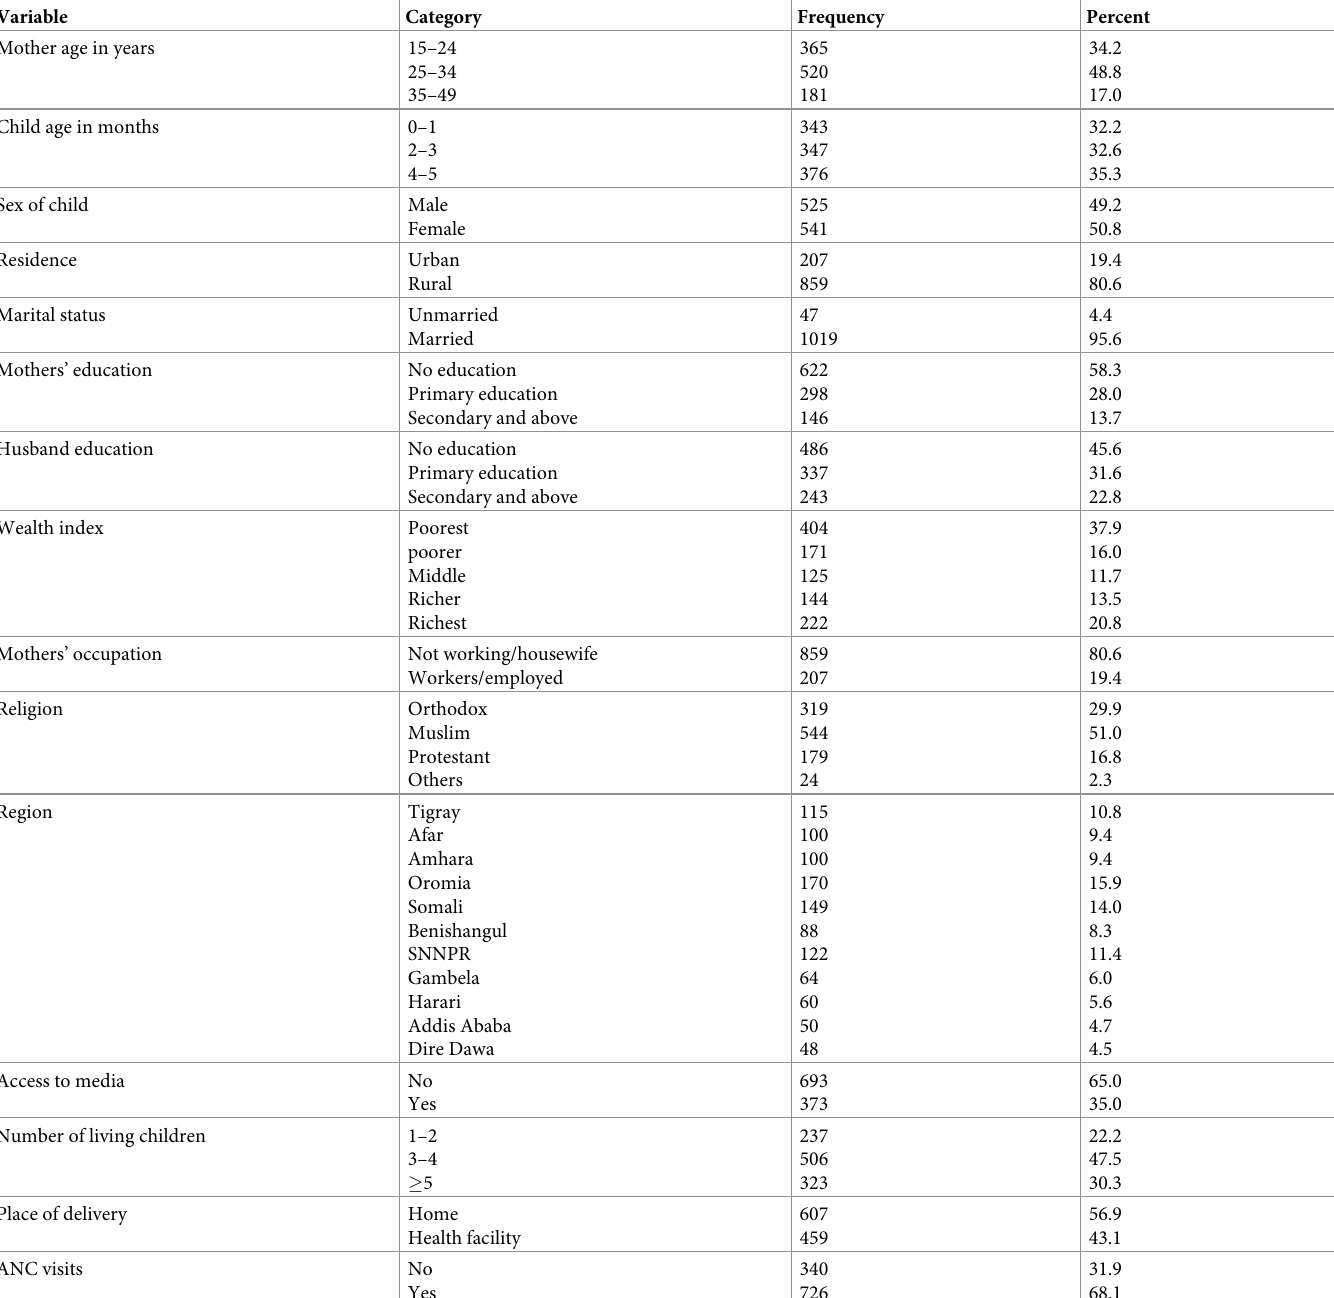
Table 1. Result of mother’s characteristics of exclusive breastfeeding in Ethiopia, EDHS